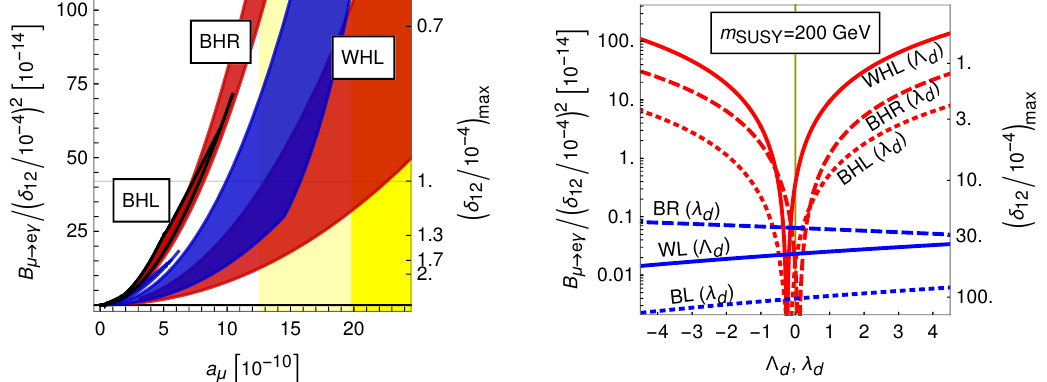
Figure 8. Left: correlation between a (cid:22) and B (cid:22) e(cid:13) in the WHL, BHL, BHR scenarios, for ! (cid:21) d ; (cid:3) d = 1 (blue) and = 4 (red). The signs for the (cid:3) d ; (cid:21) d are chosen as in (cid:12)gures 5, 6(left). j j j j The axis on the left shows B (cid:22) e(cid:13) for the (cid:12)xed value of the appropriate (cid:14) 12 = 10 (cid:0) ! the right shows the maximum (cid:14) 12 allowed by the MEG limit (3.7), see text for details. The very small blue region corresponds to BHR ( (cid:21) d = 1); the black edgy contour corresponds to the BHL region with (cid:21) d = 4; the BHL region with (cid:21) d = 1 is invisibly small. Right: detailed dependence of j j j j B (cid:22) e(cid:13) on (cid:3) d ; (cid:21) d in the WHL, BHL, BHR, WL, BL, BR scenarios. In each scenario only one of !